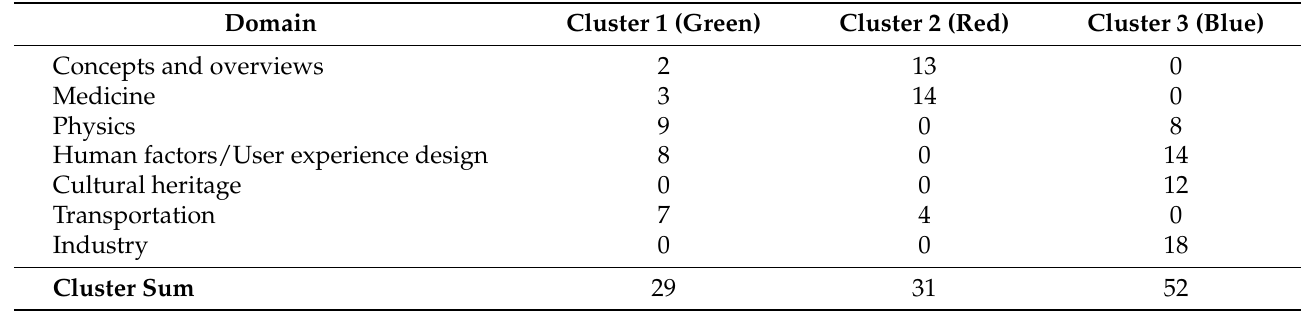
Table 9. Number of works per domain in each